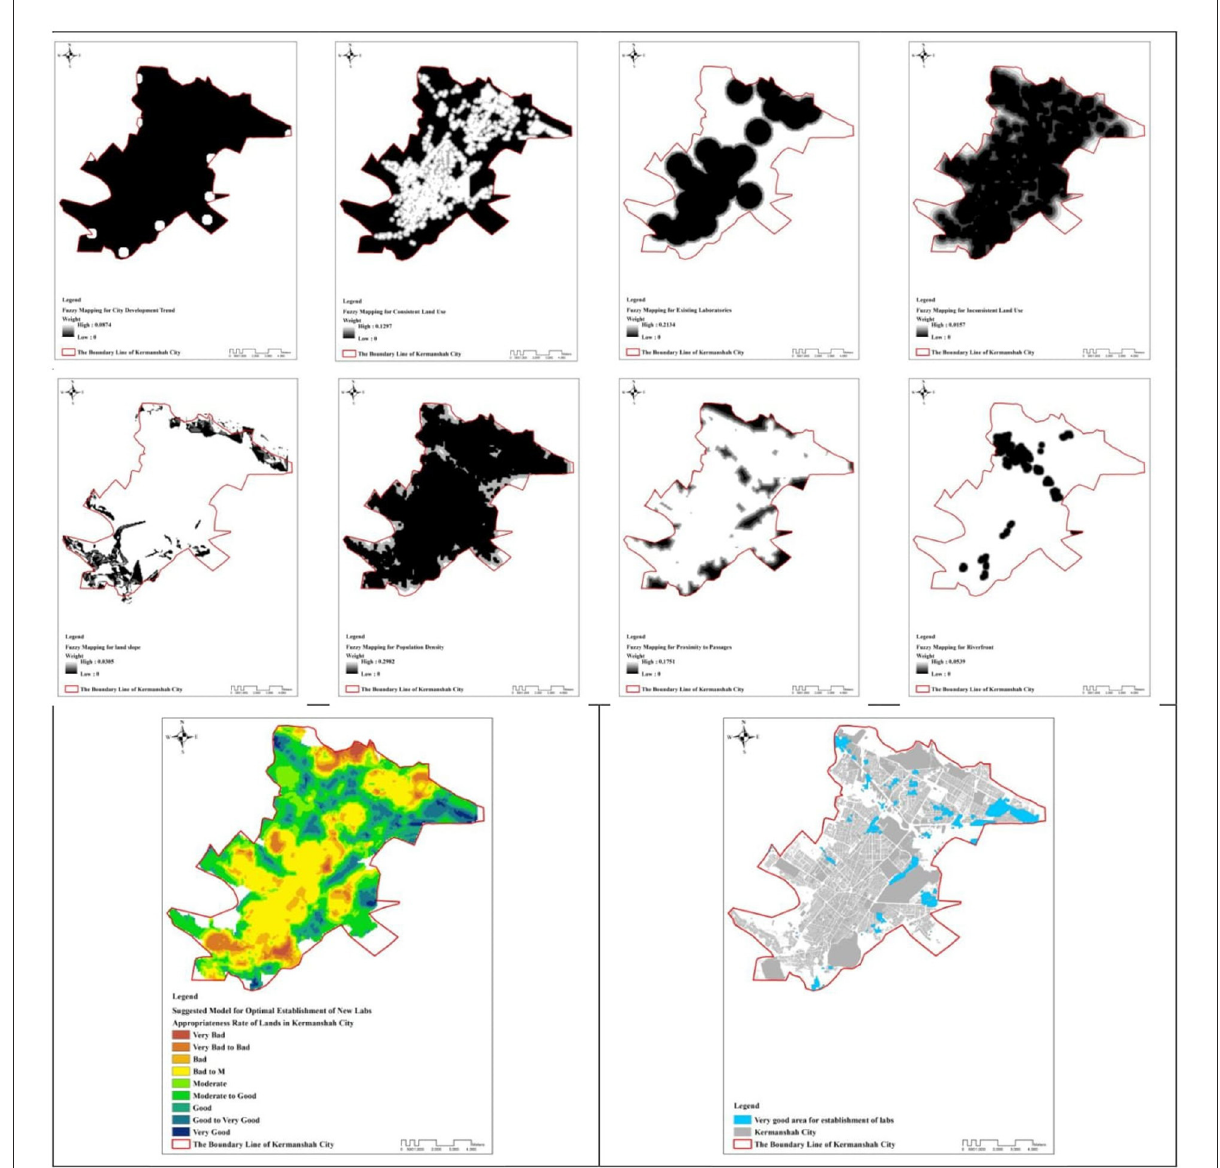
FIGURE2 Fuzzy mapping for layers and suggested model for optimal establishment of new